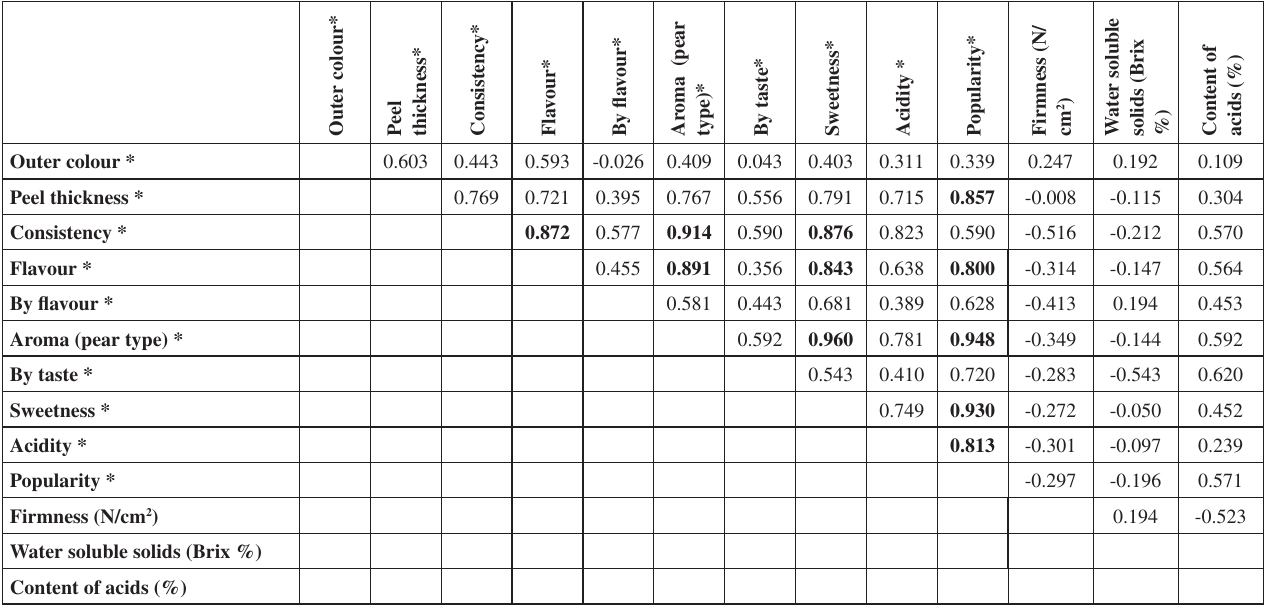
Table 2. Matrix of correlations between sensorial scores and data obtained by laboratory tests on pear fruits (n=13)